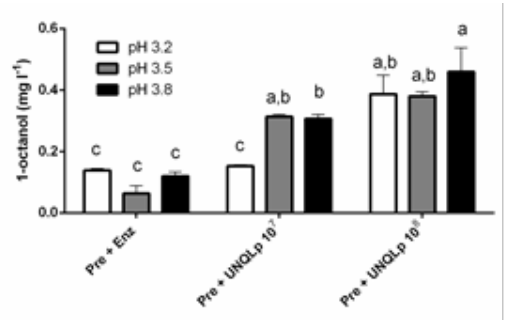
Figure 5. Release of 1-octanol in sterile Pinot Noir wine supplemented with precursor (Pre) and fermented with UNQLp11 (inocula: 1 × 10 7 or 1 × 10 8 CFU/mL) or with the commercial enzyme, for 15 days at 21 ◦ C. Wines present different pH values (white bars 3.2, gray bars 3.5, and black bars 3.8). Different letters (a, b, c) represent groups with significant differences ( p < 0.05). The statistical analysis was done with ANOVA and posterior Tukey